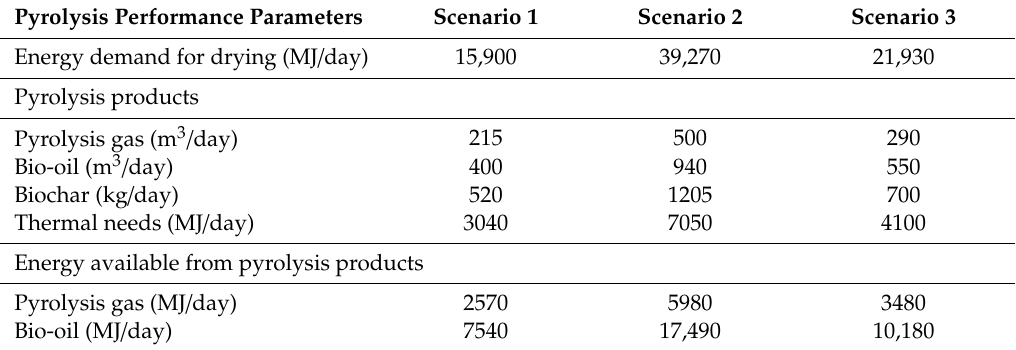
Table 3. Performance parameters associated with pyrolysis of digestates.